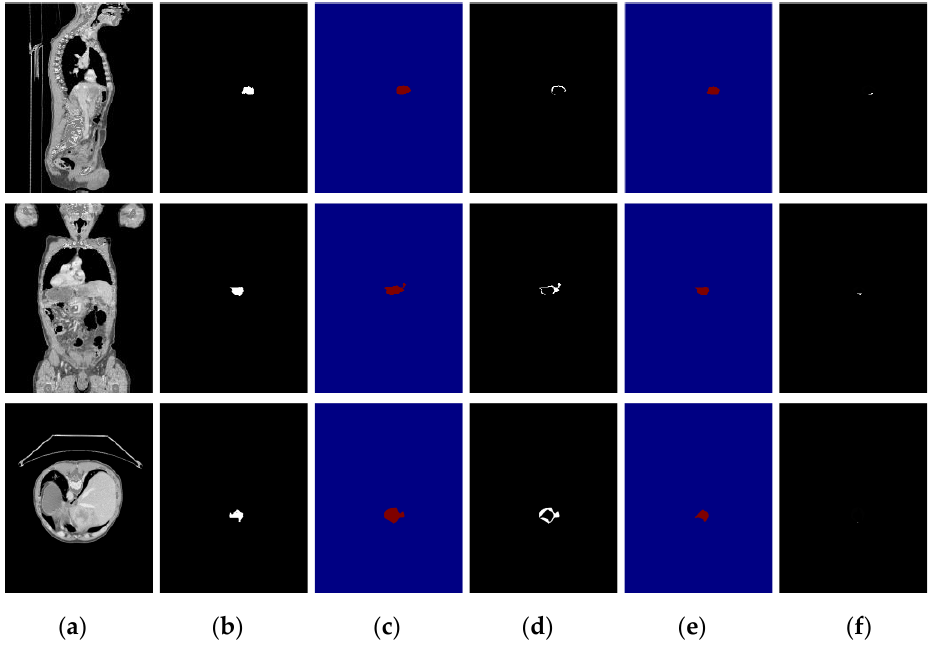
Figure 13. Segmentation result of a small tumor; the first row is the sagittal plane, the second row is the coronal plane, and the third row is the transverse plane. ( a ) CT image; ( b ) Ground truth; ( c ) DenseUNet segmentation results; ( d ) difference image between DenseUnet and ground truth; ( e ) the proposed algorithm’s segmentation results; ( f ) difference image between the proposed algorithm and ground truth.